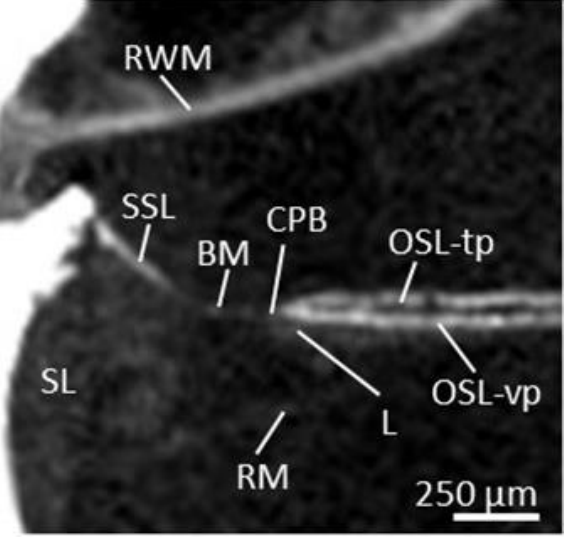
Figure A2. An enlargement of the microCT image in Figure 1E, which corresponds to the OCT image in Figure 1B.